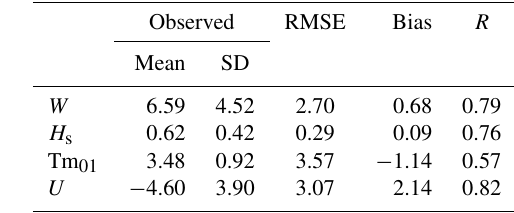
Table 2. Statistics for the comparison between buoy measurements and model outputs. W is the wind intensity (in ms − 1 ), H s is the significant waves height (in m), Tm 01 is the mean wave period (in s) and U is the depth-averaged along-shelf current (in cms − 1 ; positive north-eastward). The statistical parameters are the root mean square error (RMSE), the bias and the correlation coefficient ( R ).